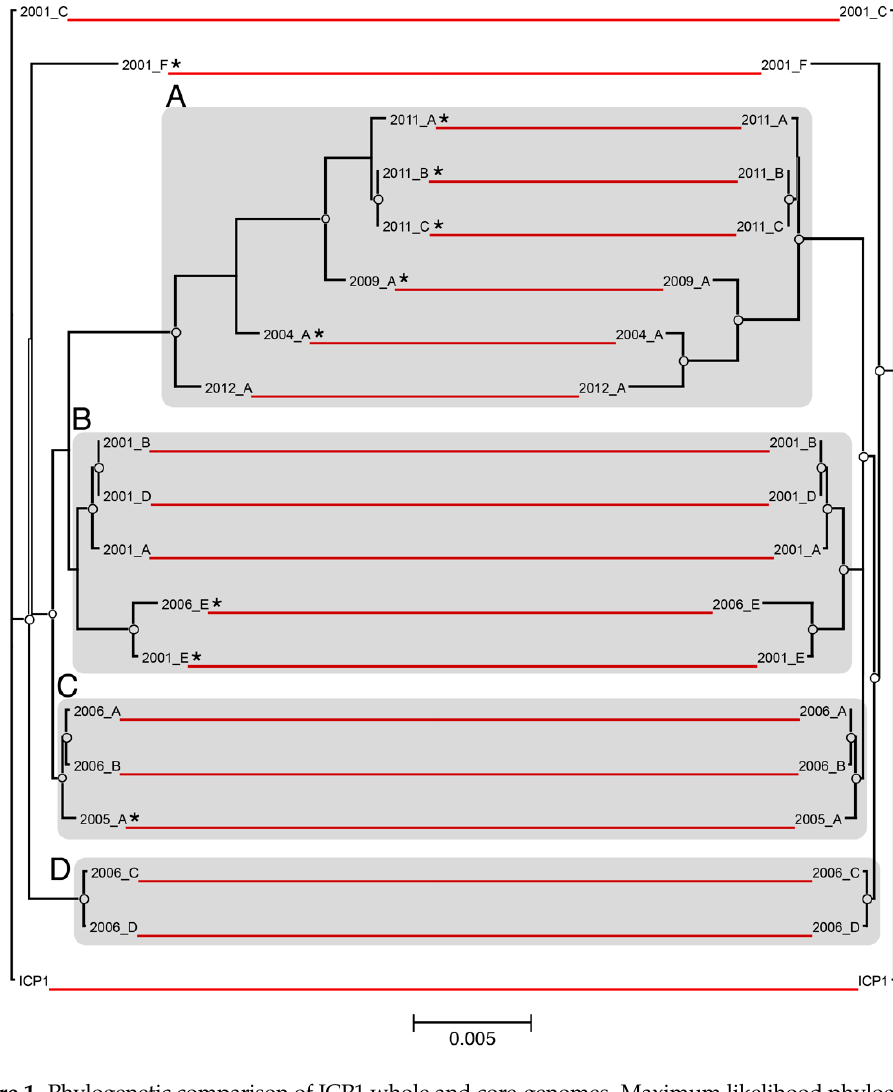
Figure 1. Phylogenetic comparison of ICP1 whole and core-genomes. Maximum likelihood phylogenetic trees (unrooted) were constructed based on a multiple whole-genome alignment of all 19 ICP1 phage sequences ( left ), as well as an alignment of the concatenated ORFs for each phage that comprise the core genome ( right ). The red lines connect identical leaves between trees to indicate relative phylogeny. The circles represent nodes with ≥ 90% bootstrap support ( n = 100). The scale bar measures nucleotide substitutions per base pair. Distinct phylogenetic clusters are shaded grey, and CRISPR strains are marked with